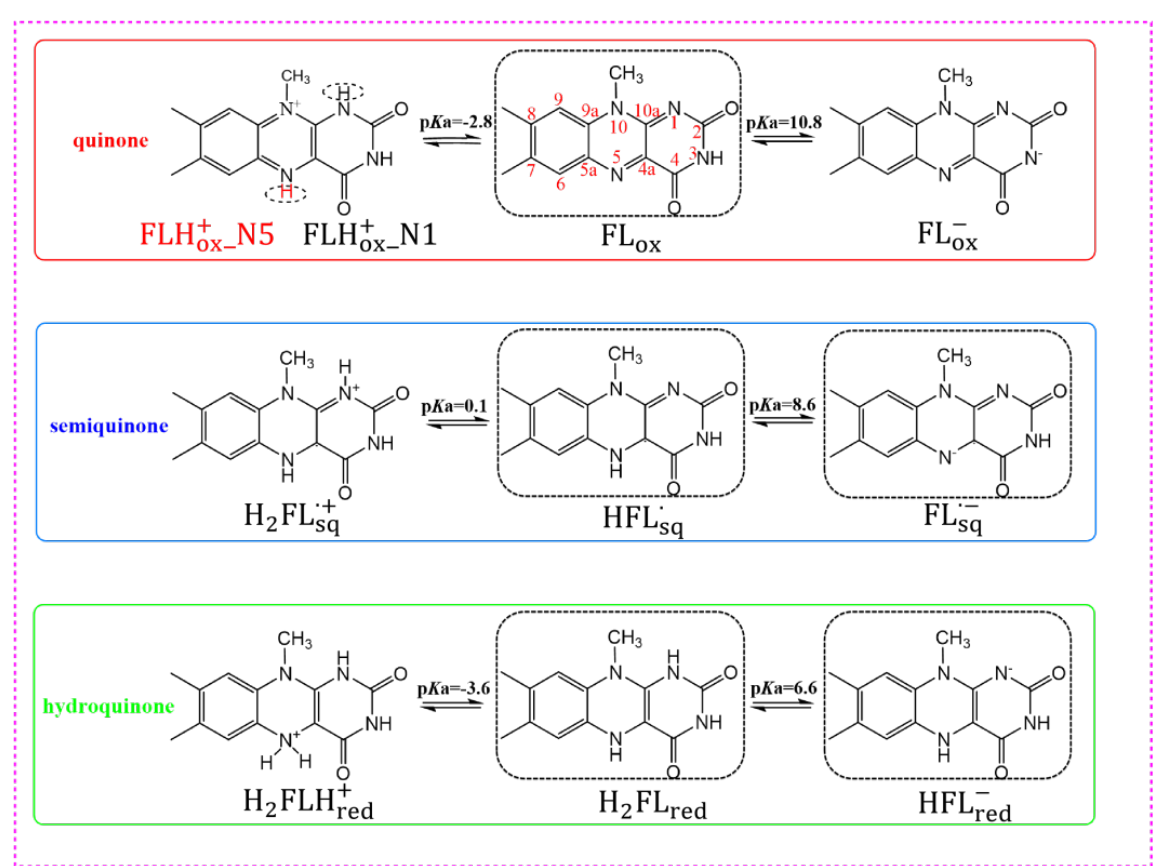
Figure 1. Structures and acid-base equilibrium of flavins and labels. The molecules in the black dotted box are the forms that exist under physiological conditions.